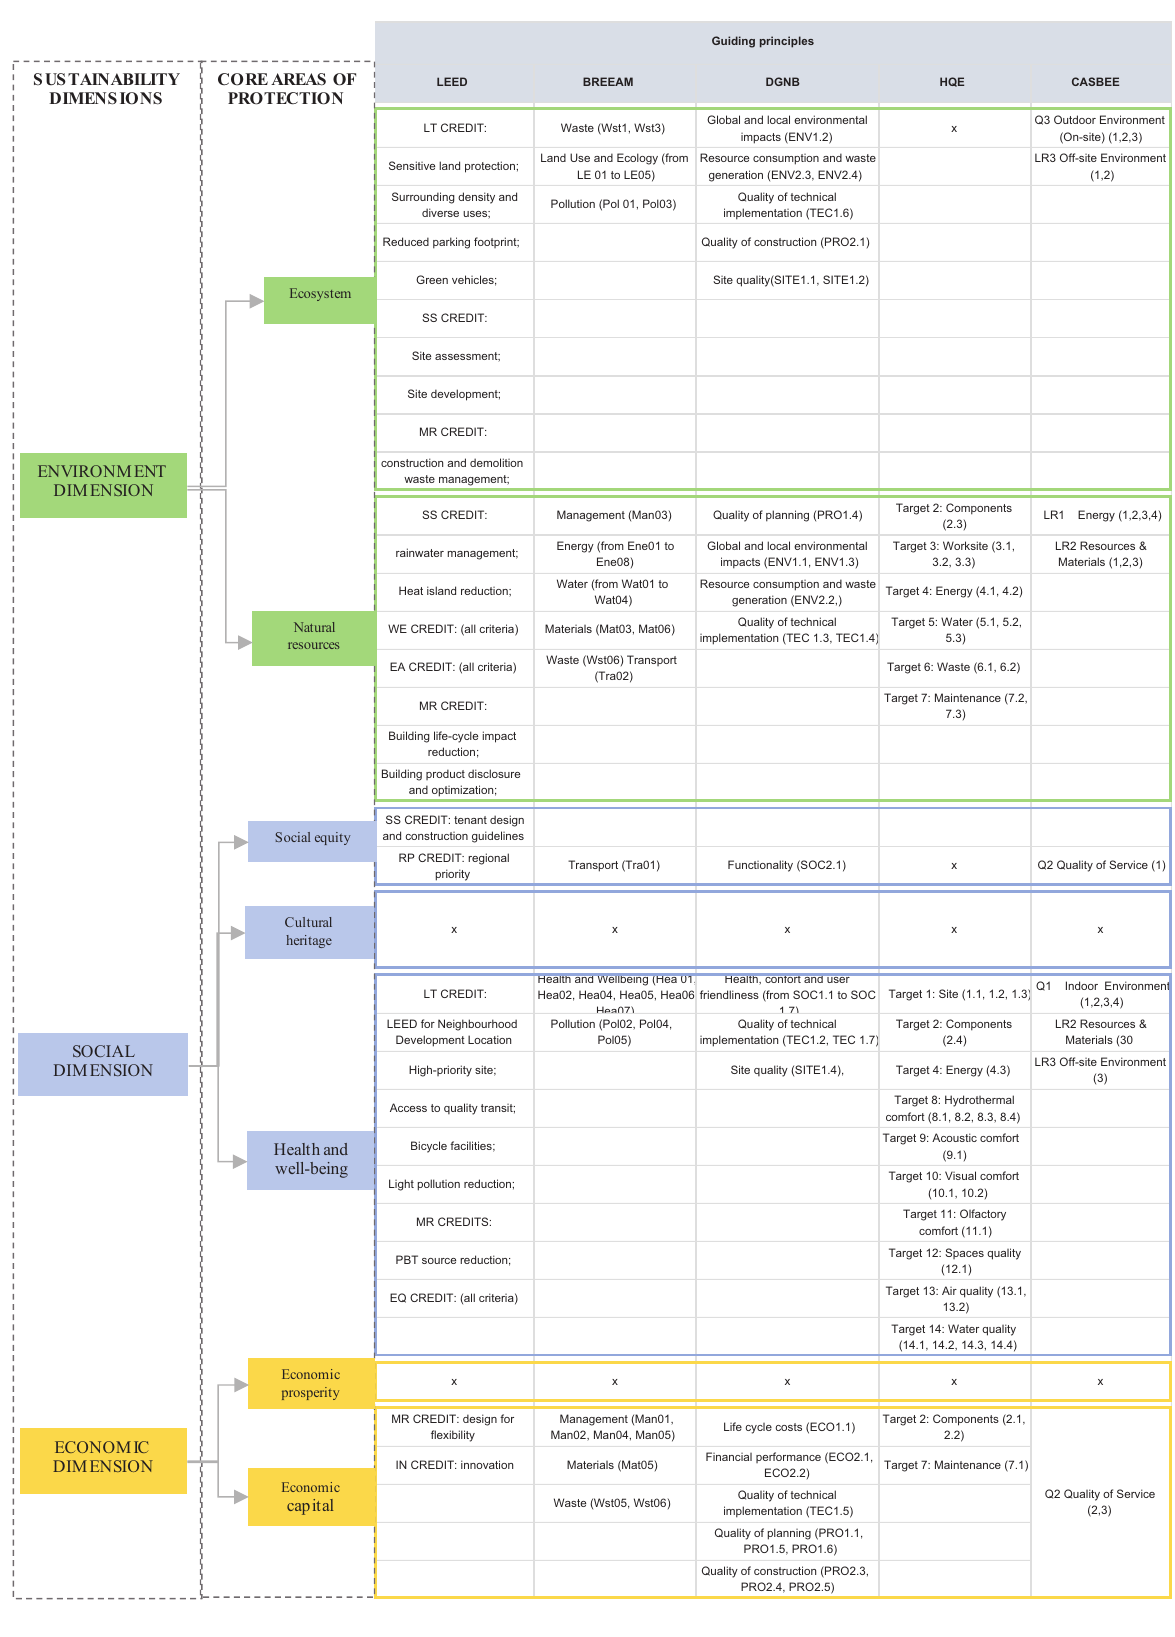
Figure 3. Scheme of the rating bodies’ criteria in accordance with the ISO 21929-1 core premises and the sustainability dimensions (source: elaborated by the